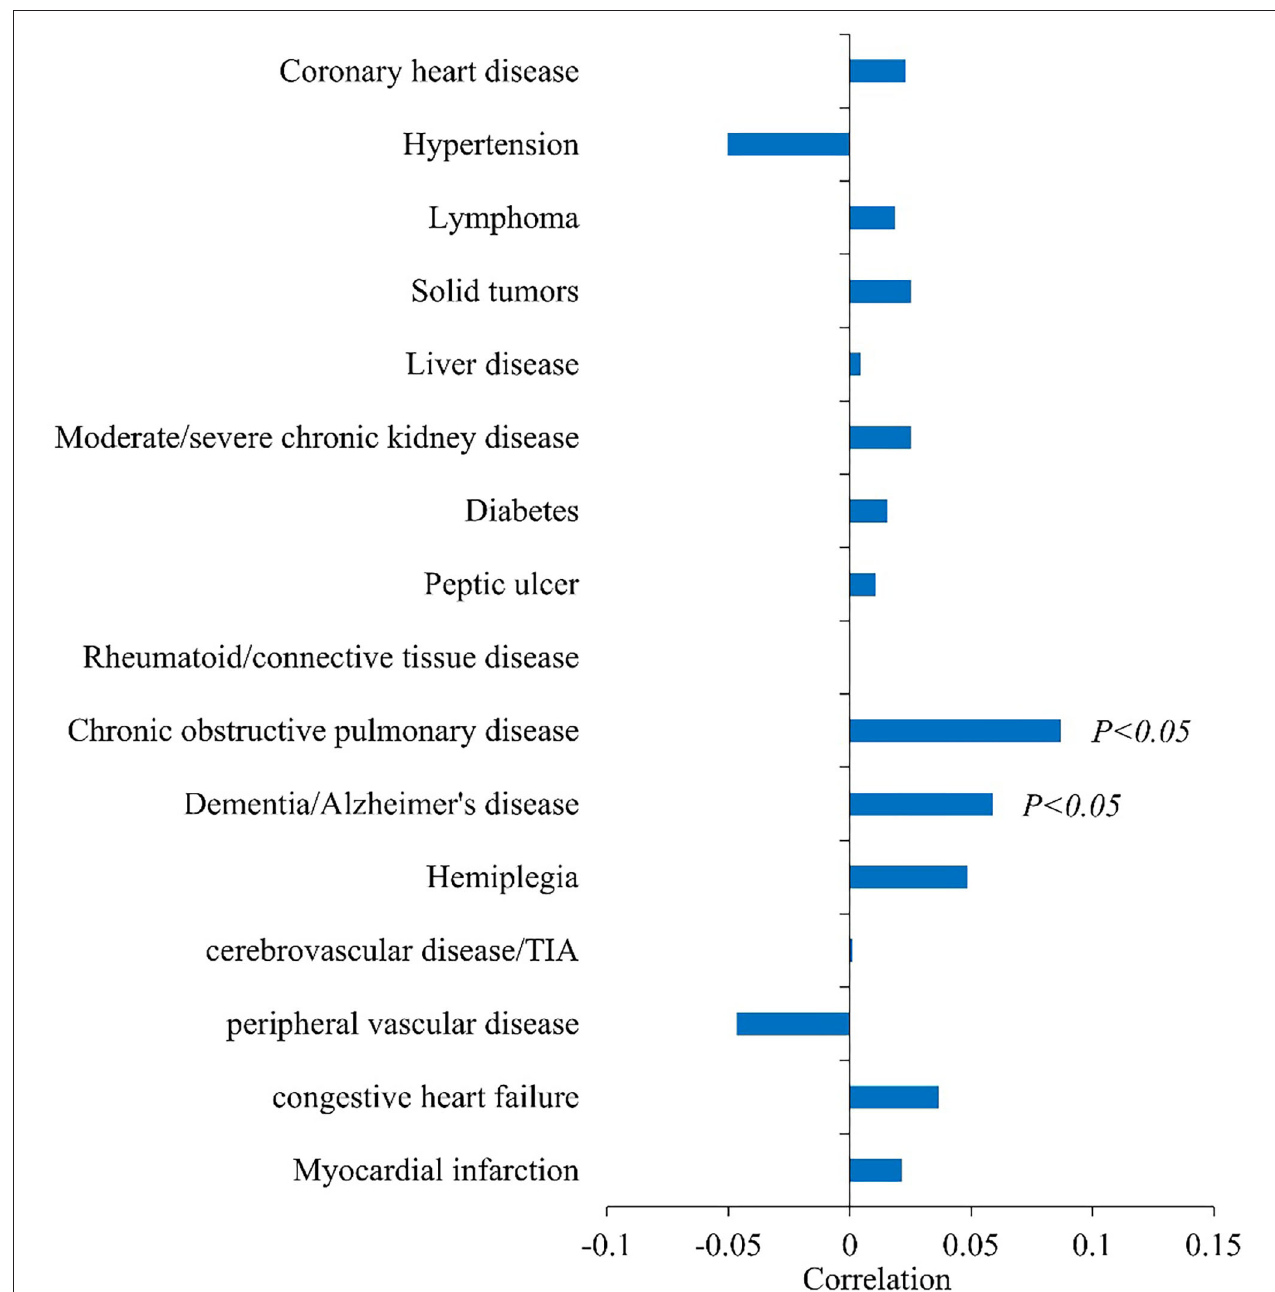
FIGURE 1 | Correlation analysis between basic diseases and infection outcomes (Spearman’s correlation coefficient in abscess).